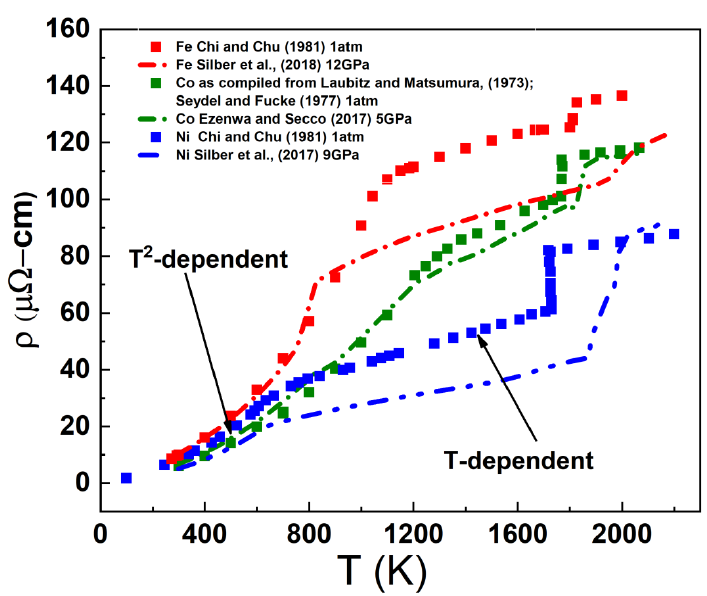
Figure 3. Temperature dependence of resistivity of solid and liquid Fe, Co, and Ni at 1 atm and at various high pressures. The P -dependence of liquid resistivity of Co and Ni along the melting boundary appears constant up to 5 GPa and 9 GPa, respectively, with values of resistivity on melting (𝜌 𝑙𝑖𝑞 ) comparable to their corresponding values at 1 atm. The resistivity of Fe on melting decreases up to 5 GPa as it melts from the bcc phase but then resistivity on melting remains constant up to 12 GPa as it melts from the fcc phase. With a constant value of resistivity on the melting boundary, 𝜌 𝑙𝑖𝑞 , and a decreasing value of solid resistivity just before melting (𝜌 𝑠𝑜𝑙 ) with increasing P , 𝜌 𝑙𝑖𝑞 − 𝜌 𝑠𝑜𝑙 increases with increasing P up to the maximum pressures investigated in these studies as shown in Figure 4. Although, these data for Fe show an increasing 𝜌 𝑙𝑖𝑞 − 𝜌 𝑠𝑜𝑙 with increasing P in this low P range, theoretical calculation [28] up to core P and T show that the 𝜌 𝑙𝑖𝑞 − 𝜌 𝑠𝑜𝑙 for Fe melting from the hcp phase decreases with increasing P . Further experimental work is needed at higher P to assess the trend of 𝜌 𝑙𝑖𝑞 − 𝜌 𝑠𝑜𝑙 for Fe shown here within the context of a larger pressure range.